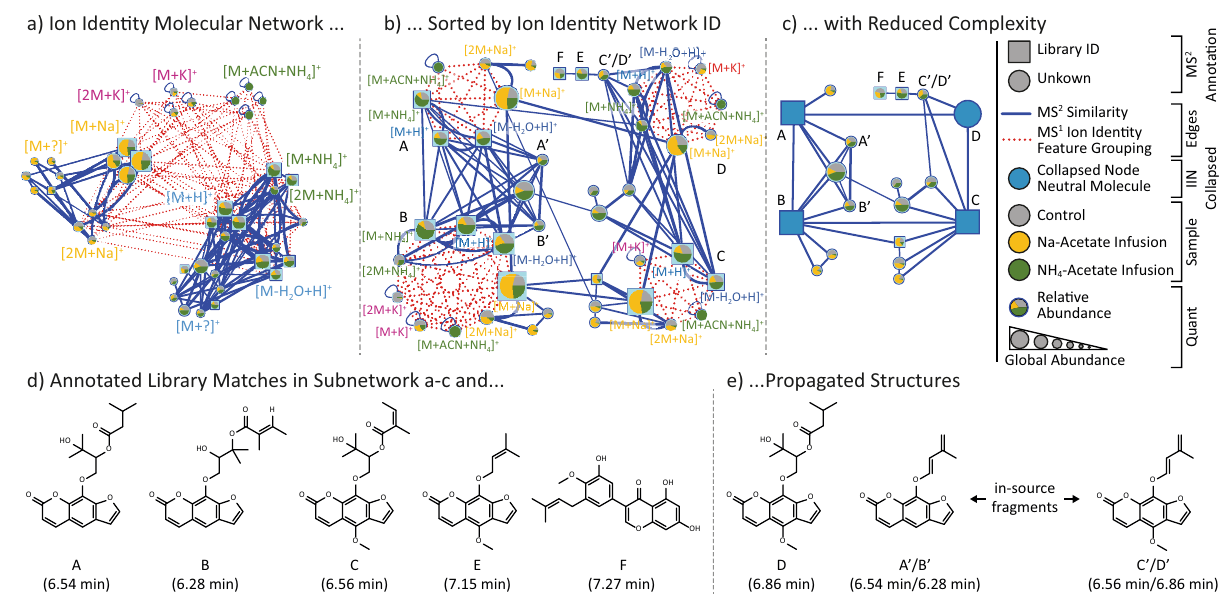
Fig. 2 Ion identity molecular networking. Depicted are three visualizations of the same ion identity molecular network from the post-column salt infusion experiments. a Sorting by ion identities reveals that MS 2 similarity edges (blue) often link sodiated ions (e.g., [M + Na] + and [2 M + Na] + ) into a subnetwork that is separated from a subnetwork of ammonium adducts with protonated species. The pie charts indicate relative abundances in different salt addition experiments (Control (H 2 O), gray; Na-Acetate, yellow; NH 4 -Acetate, green). The complexity and redundancy are reduced by b sorting all ions of the same molecule in a circular layout and c collapsing all IIN into representative single molecular nodes. This option reduces the complexity of this IIMN from 43 feature nodes to four molecular nodes (A – D) and 15 feature nodes ( − 56%). d Lists the structure of all GNPS library matches and e propagated structures for D (based on A and C) and the in-source fragments A ’ to D ’ . This subset of structurally related compounds gives a fi rst statistical proof for high correct annotation rates during IIN in MZmine as adduct formation responds to the corresponding salt infusion, e.g., higher [M + Na] + abundances in the sodium acetate buffer